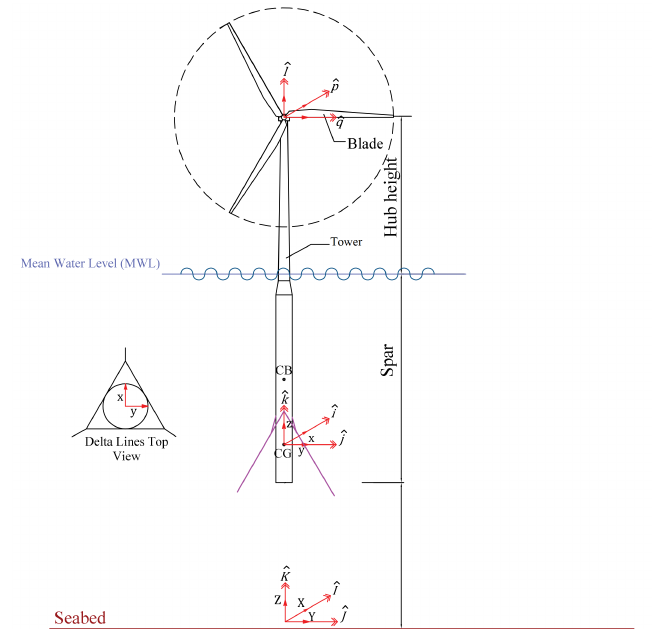
Figure 7. Configuration of a spar-type FOWT and the used coordinate systems